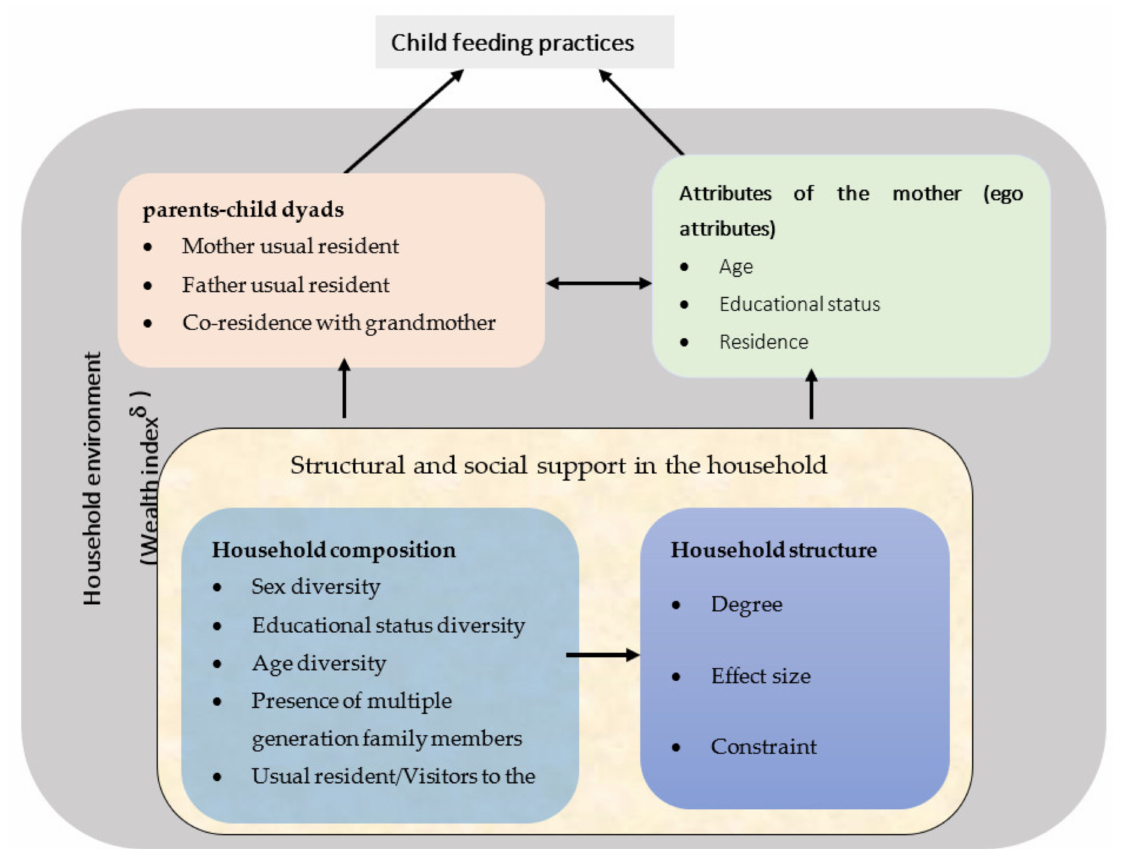
Figure 1. Modified conceptual framework of the influence of the household structure and composition on the feeding practices among children above six months of age [20,21]. δ The wealth index is a covariate related to the broader household environment, not specific to any